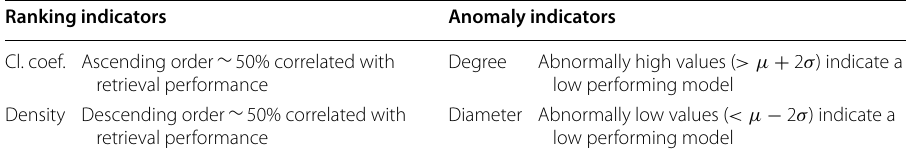
Table 9 Indicators of graph-based retrieval model performance Ranking indicators Anomaly